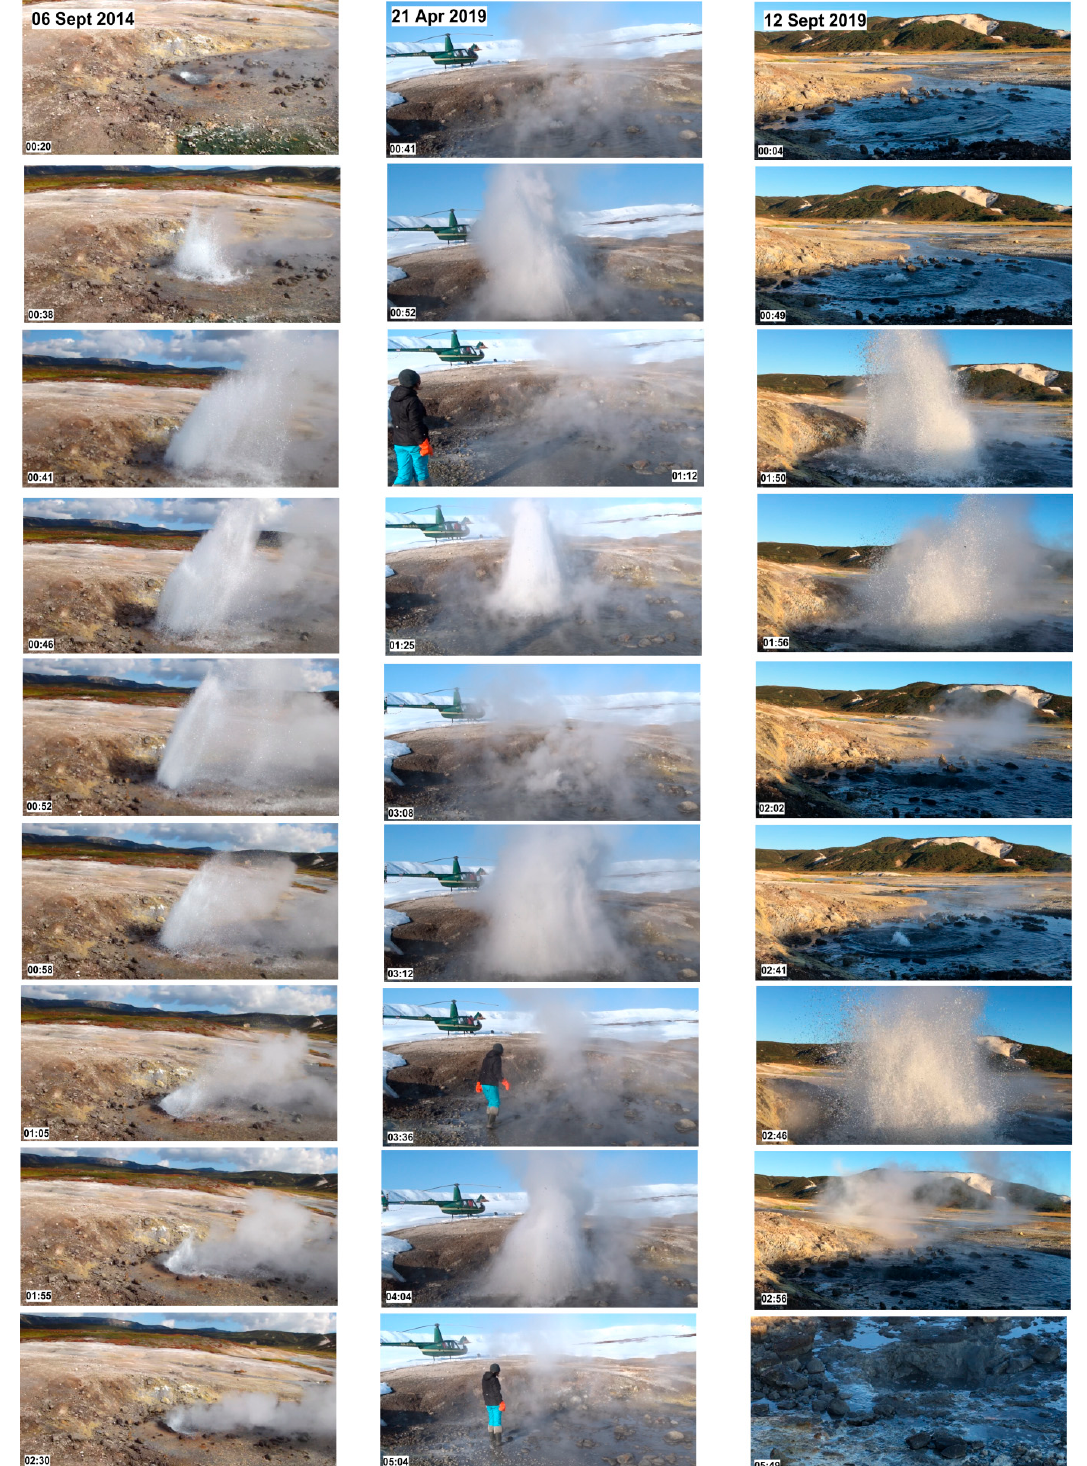
Figure A8. Shaman geyser eruptions on 06.09.2014, 21.04.2019, and 12.09.2019 and the conduit top view in 2019. Time stamp format in a left-bottom minutes:seconds. (photo by A. Kiryukhin (06.09.2014, 21.04.2019) and N. Ostrik (12.09.2019)).